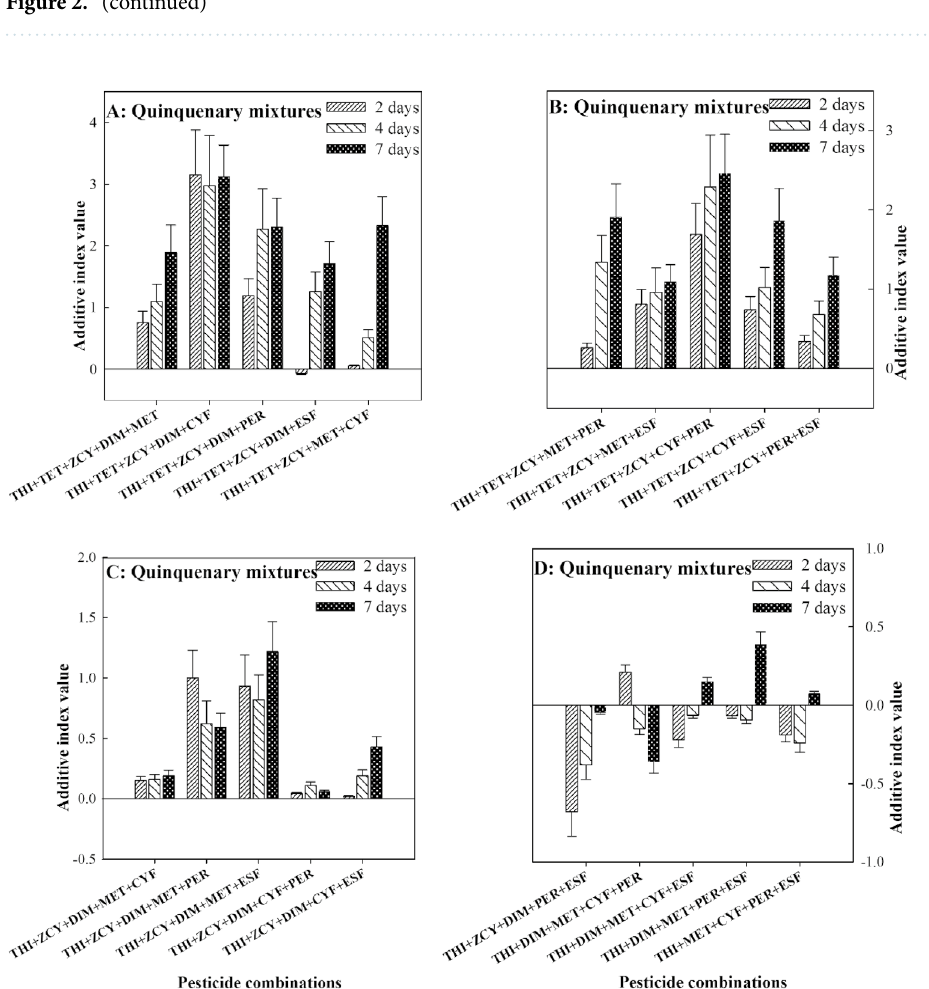
Figure 3. Joint toxic effects of quinquenary combinations of thiamethoxam (THI) mixed with seven pesticides on honey bees. CI confidence interval, THI Thiamethoxam, TET Tetraconazole, ZCY Zeta -cypermethrin, DIM Dimethoate, MET Methomyl, CYF Cyfluthrin, PER Permethrin, ESF